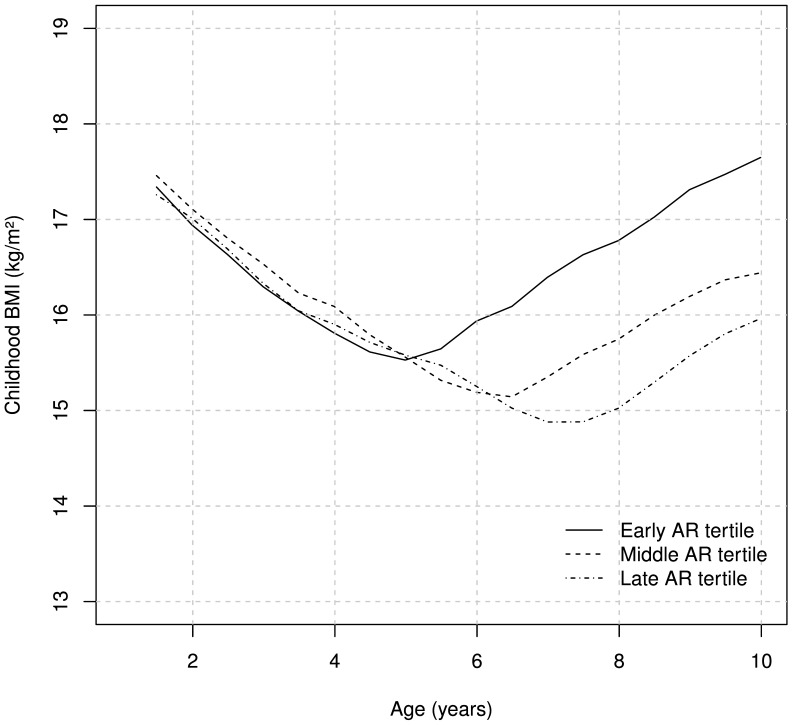
Childhood BMI plotted for tertiles of age at AR.Values are given as means. BMI = Body Mass Index, AR = Adiposity rebound. p<0.001 from 6 years of age for the middle and late AR tertiles versus the early AR tertile. p<0.05 from 7 years of age for the late AR tertile versus the middle, and for middle AR tertile versus early at 4 years of age.